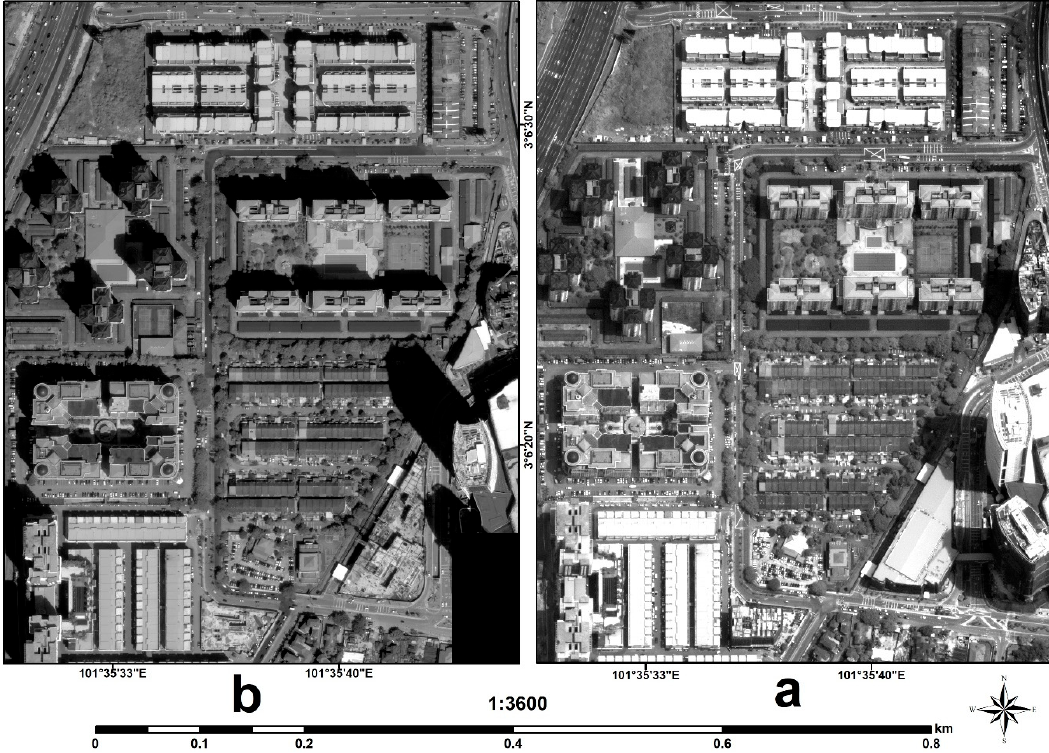
Figure 9. ( a ) Original basic WV-3 PAN band and ( b ) orthorectified image using NN systematic with 80 GCPs.